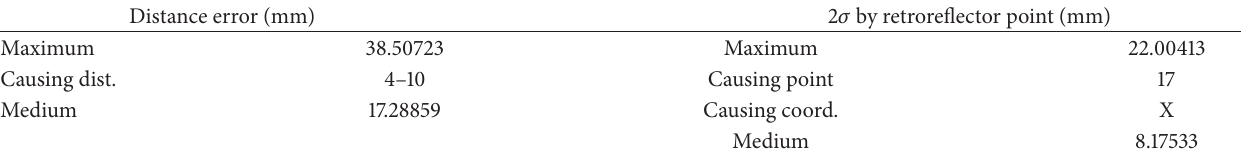
Table 3: Quality indicators for the initial values of model parameters over 21 SMR locations (105 AACMM positions). Distance error (mm)